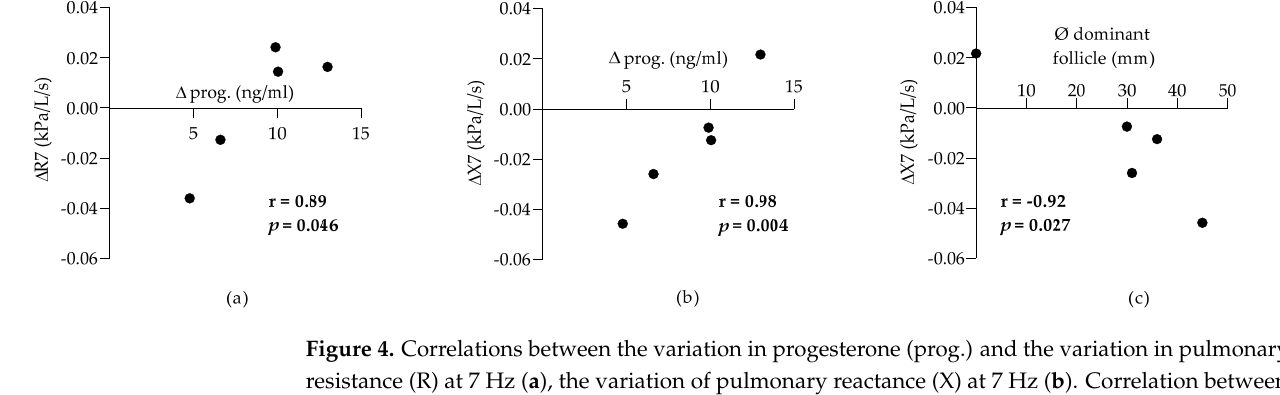
Figure 4. Correlations between the variation in progesterone (prog.) and the variation in pulmonary resistance (R) at 7 Hz ( a ), the variation of pulmonary reactance (X) at 7 Hz ( b ). Correlation between the diameter (Ø) of the dominant follicle in the follicular phase and variation in pulmonary X at 7 Hz ( c ).